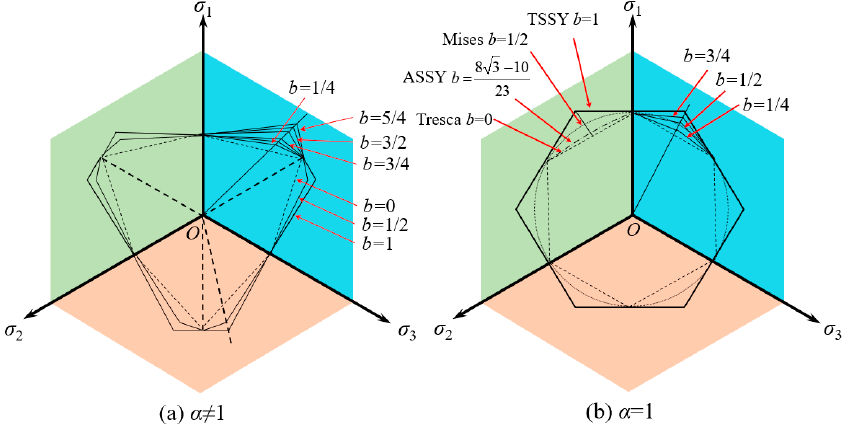
Figure 4. The yield surfaces of the unified strength theory.